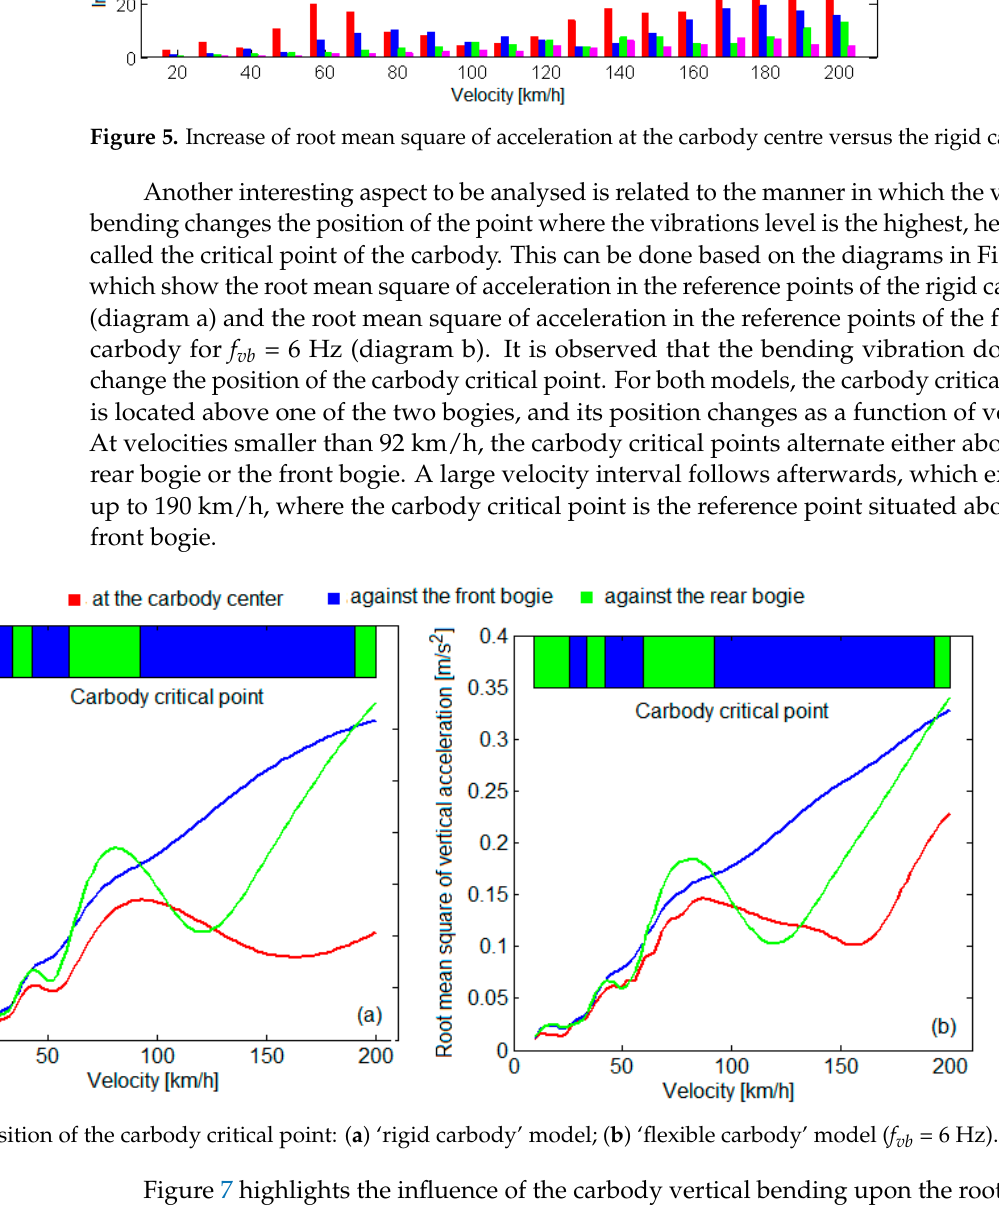
Figure 5. Increase of root mean square of acceleration at the carbody centre versus the rigid carbody.